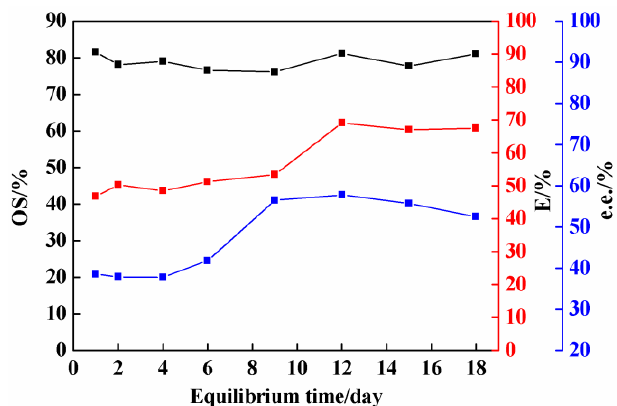
Figure 2. Effect of equilibrium time on the resolution of 3-chloromandelic acid (3-ClMA) by LEV (LEV = 2.58 mmol; 3-ClMA = 2.58 mmol; acetonitrile = 1.5 mL; crystallization temperature = −15 °C).